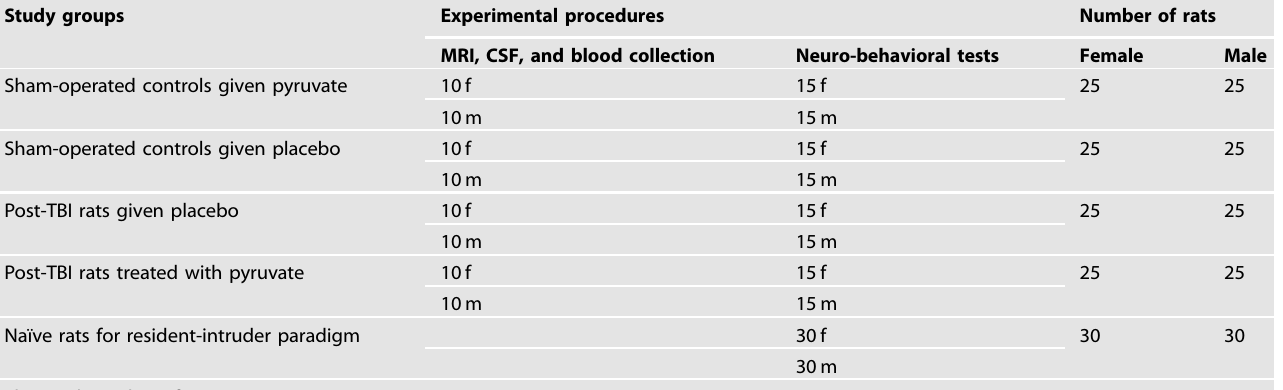
Table 1. The total number of rats in each of the experimental groups (excluding 6 male and 7 female rats that died, as discussed in the Results section). Study